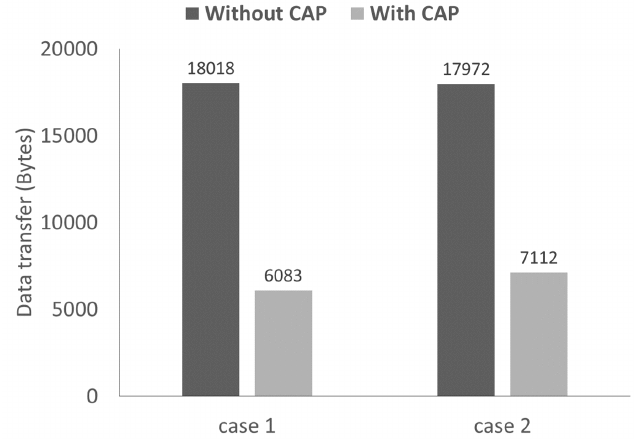
Figure 10. Amount of data sent to the network with and without a context aware